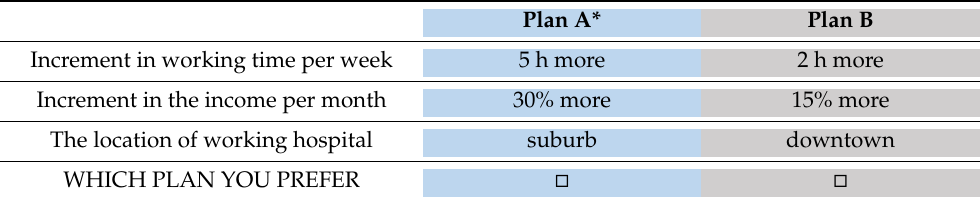
Table 2. The sample of choice